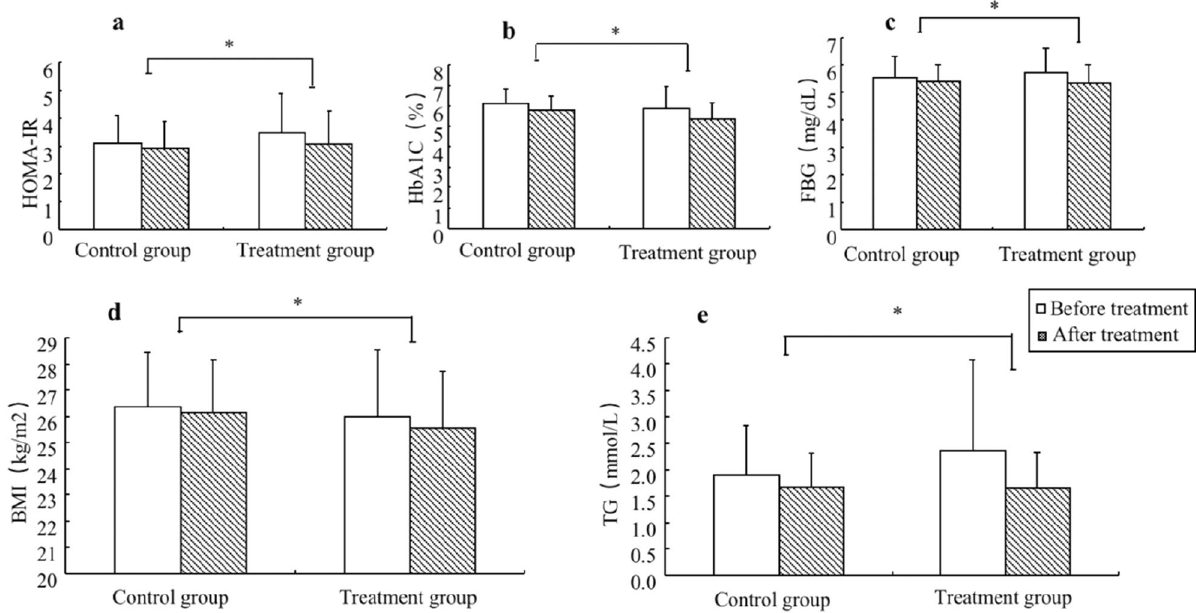
Figure 2. The treatment group presented a more robust decrease in metabolic indicators such as homeostasis model assessment of insulin resistance ( a ), glycosylated hemoglobin ( b ), fasting blood glucose ( c ), body mass index ( d ) and triglyceride ( e ) compared with the control group. * p < 0.05; HOMA-IR = homeostasis model assessment of insulin resistance, HbA1c glycosylated haemoglobin, FBG fasting blood glucose, BMI body mass index, TG triglyceride.